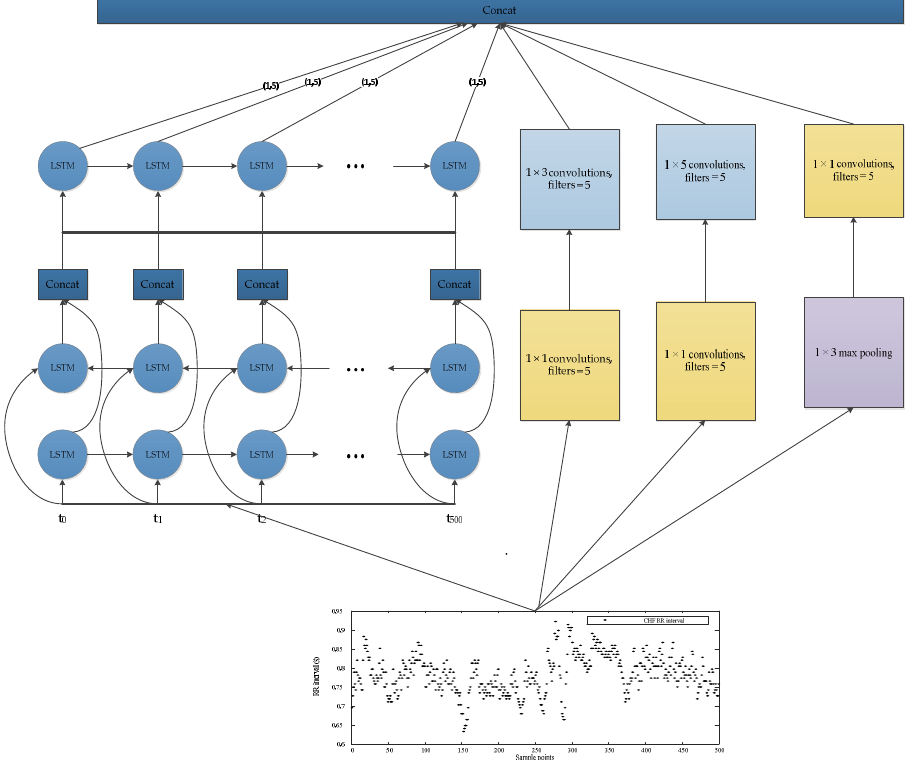
Figure 6. The detailed structure of the module in this model (the input data is 500 RR interval segments).